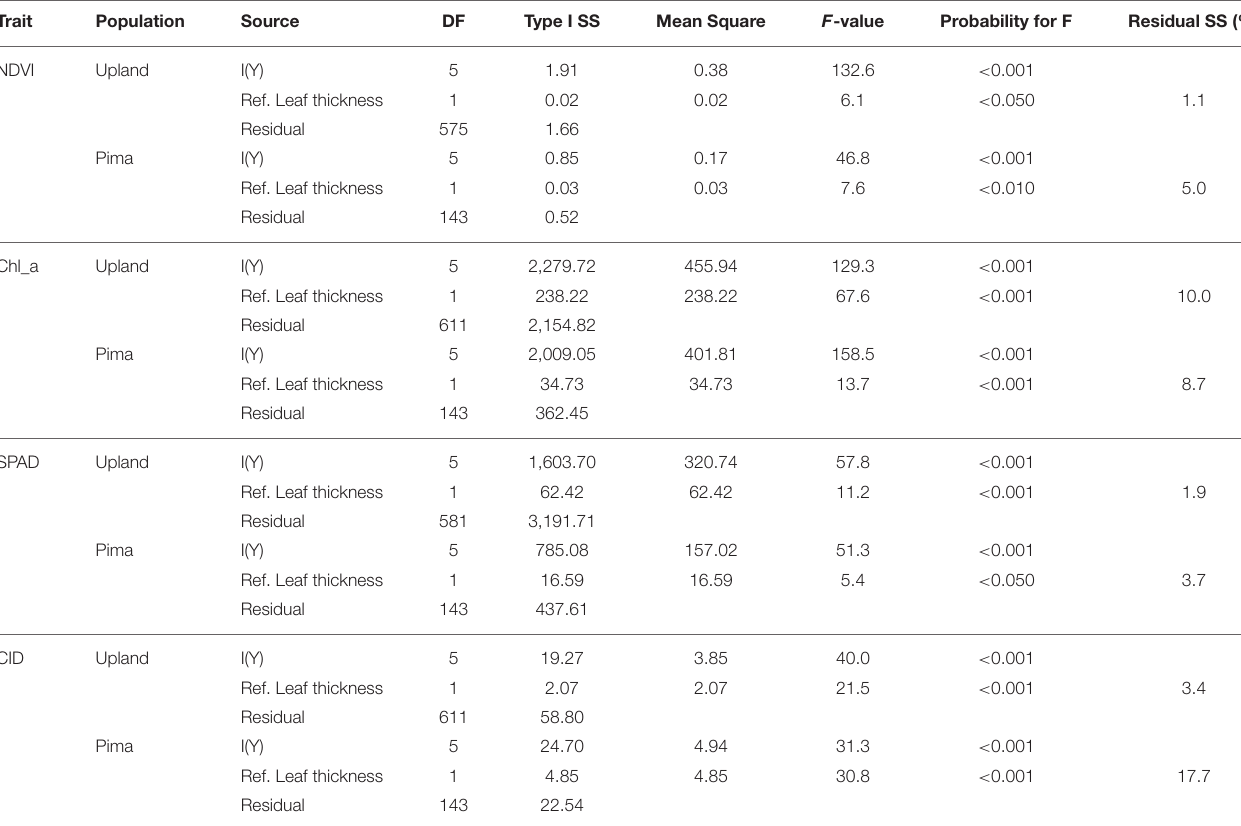
TABLE 6 | Analysis of variance (ANOVA) for multiple regressions that test for influence of reference leaf thickness on NDVI, chlorophyll a concentration, SPAD, and carbon isotope discrimination (CID) once effects of irrigation regime within years are considered. Thus, tests are for sequential (Type I) sums of squares (SS). Trait